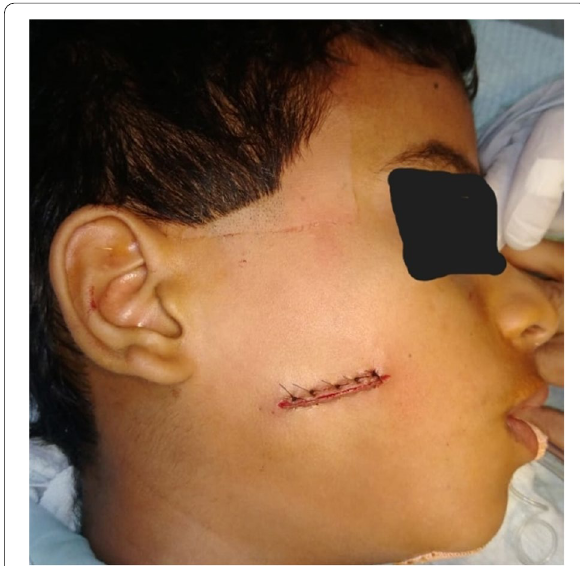
Fig. 7 Immediate post op image of the patient